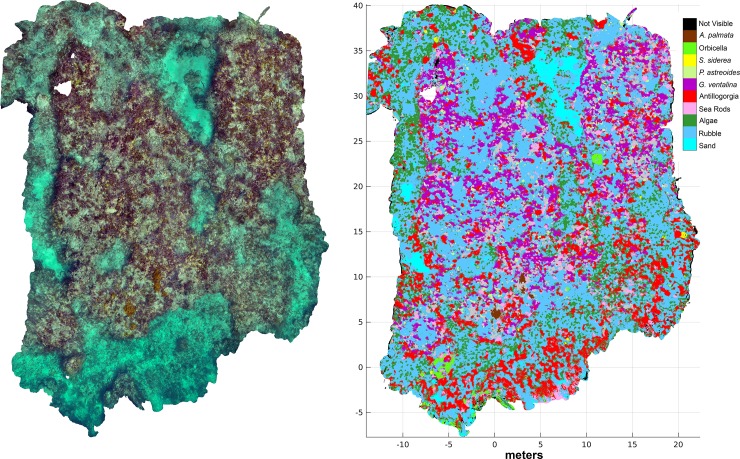
Reconstruction and classification (nViewNet-8) of a larger section of
Little Grecian reef (LG9; ~40 m x 30 m) demonstrating the potential to
expand the method to landscape scale.This figure is best viewed on a computer screen.